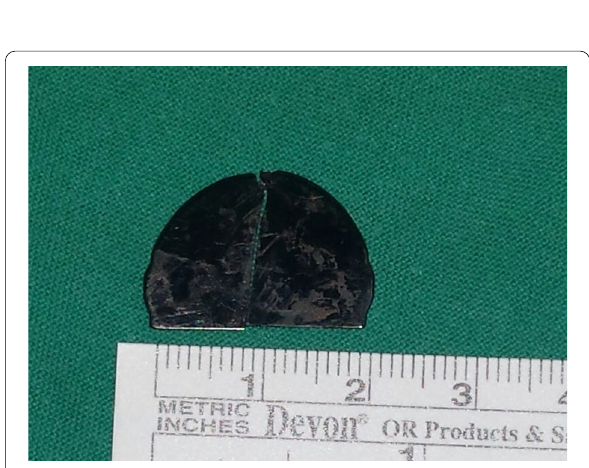
Fig. 5 The fractured and embolized leaflet extracted from the aorta and external iliac